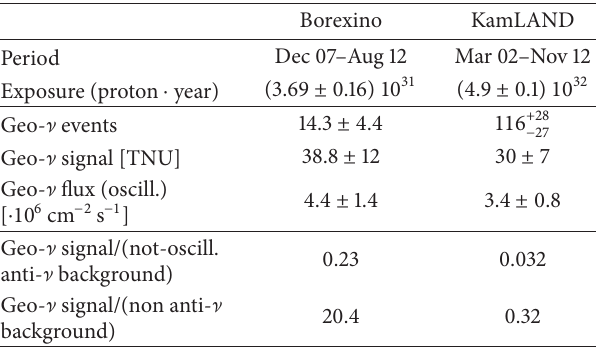
Table 4: Measured geo-neutrino signal in Borexino [62] and KamLAND